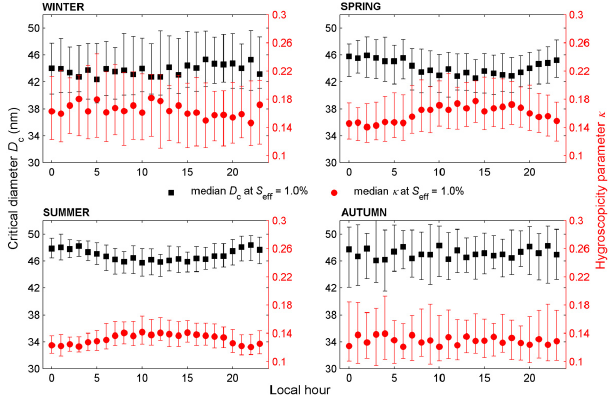
Fig. 9. Hourly median D c (black) and κ (red), shown for S eff of 1.0% and separated by seasons. Error bars are 25th and 75th per-